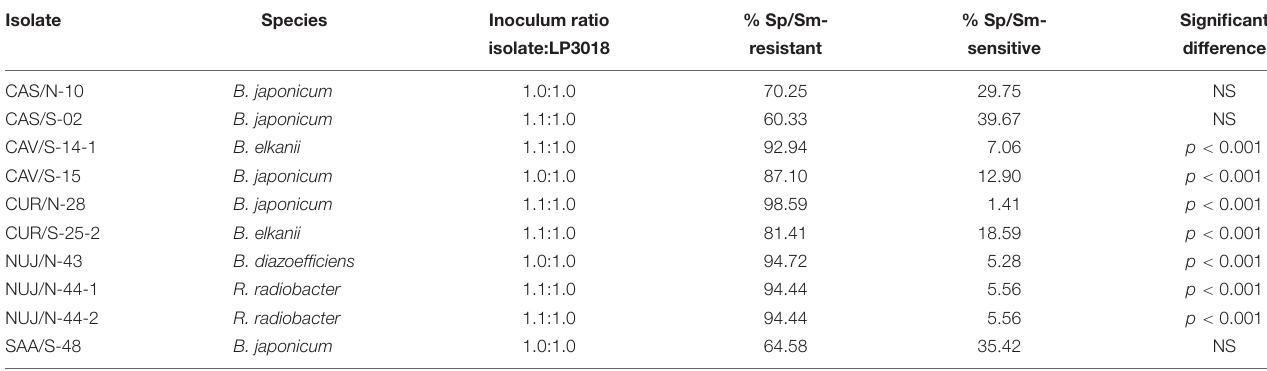
TABLE 5 | Competition for nodulation between each isolate (Sp/Sm-sensitive) and B. japonicum LP3018 (Sp/Sm-resistant spontaneous derivative from B. japonicum E109).